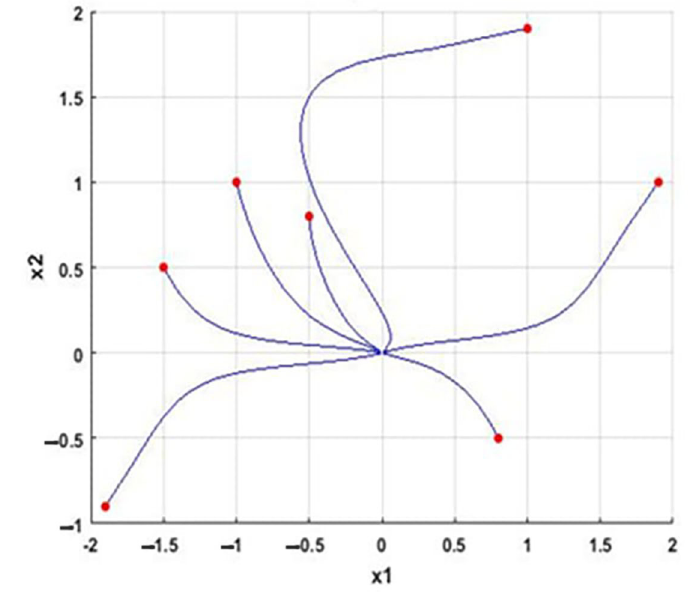
Figure 2. Phase portrait of the nonlinear system (21).